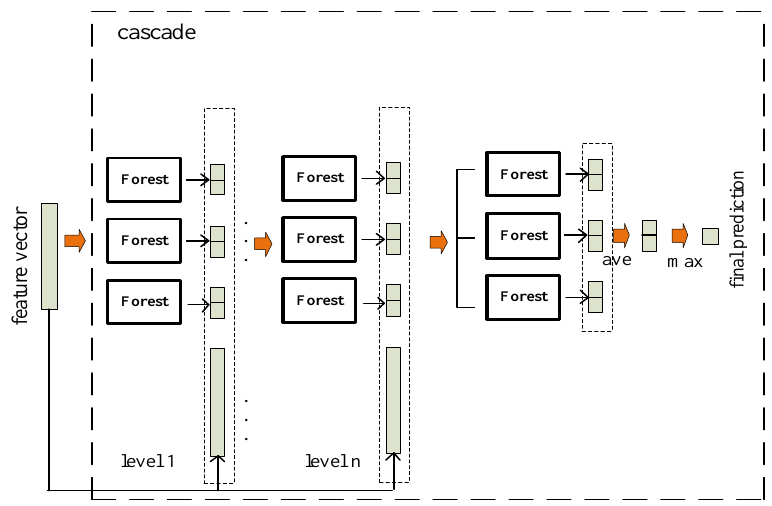
Figure 2. Illustration of the cascade forest structure. The output of each forest is concatenated for re-presentation of the original